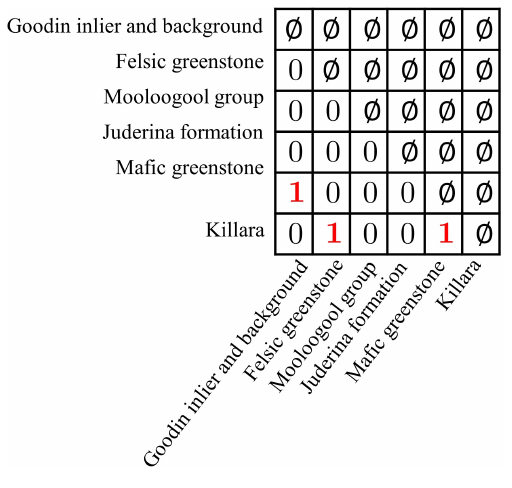
Figure 7. Matrix defining forbidden contact between lithologies in the Yerrida Basin. Here, 1 means that two units may be in con- tact with each other, 0 means that they may not, and ϕ represents symmetric relationships or when the same unit is adjacent to itself (which geologically may occur across a fault but cannot be resolved by the geophysical data available).